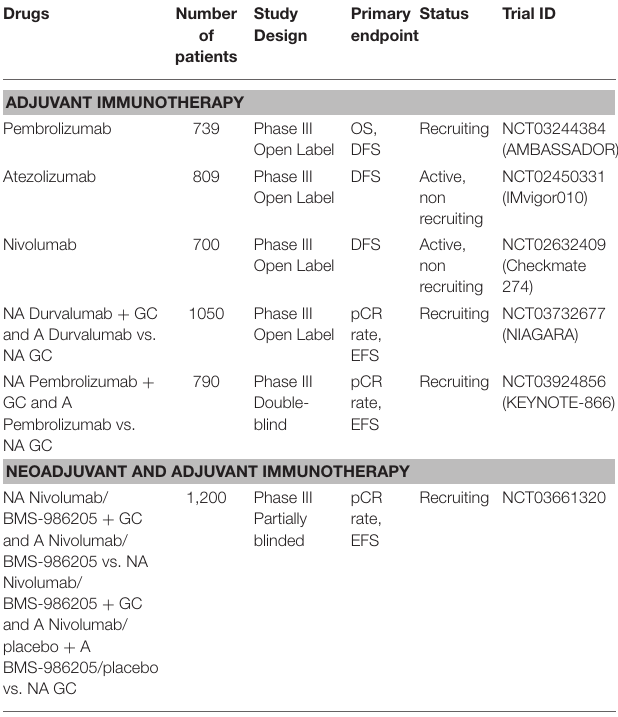
TABLE 5 | Overview of adjuvant trials in MIBC testing immunotherapy. Drugs Number of